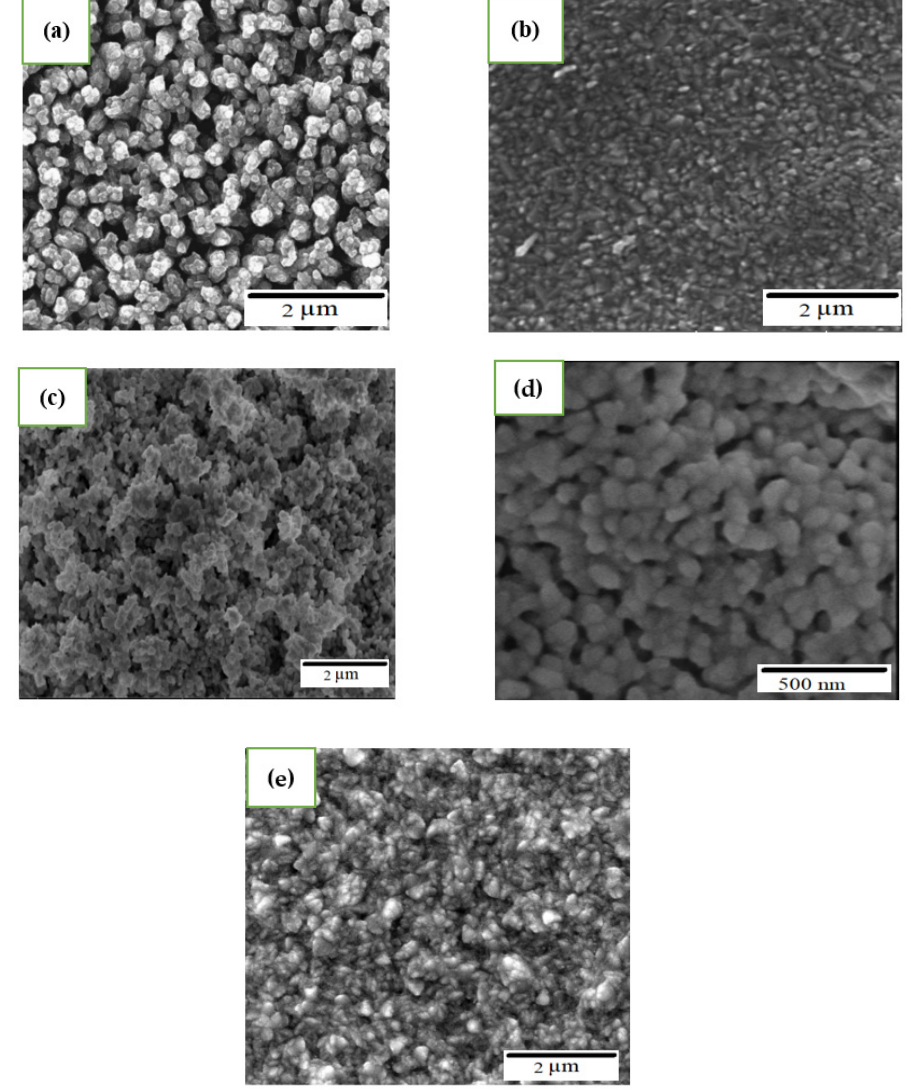
Figure 2. FESEM images of ( a ) NiO/FTO ( b ) ZrO 2 /FTO and ( c ) NiO-ZrO 2 /FTO ( d ) Y 2 O 3 /FTO ( e ) NiO- Y 2 O 3 /FTO.